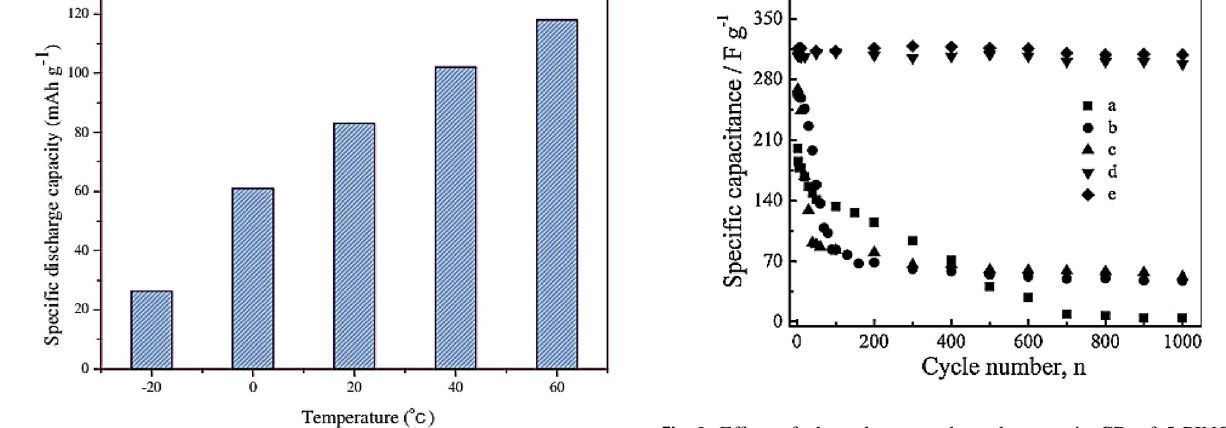
Fig. 8 Effect of electrolytes on the galvanostatic CD of 5-PINC: a ACN/LiClO 4 , b Na 2 SO 4 , c KCl, d H 2 SO 4 , and e HClO 4